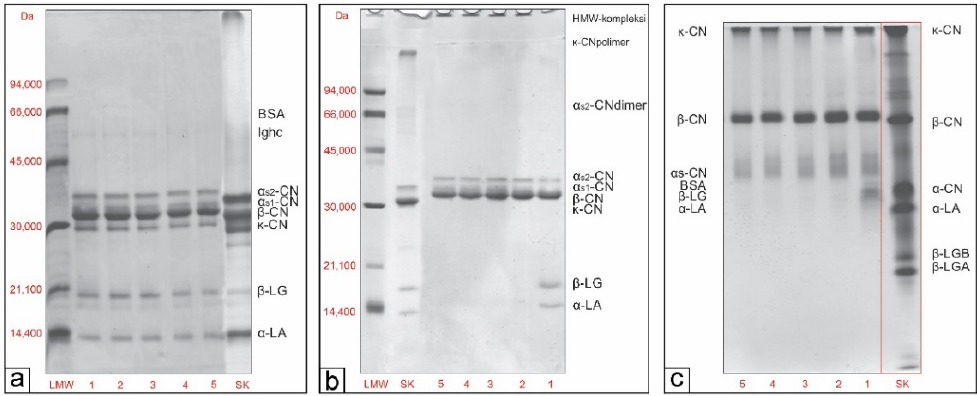
Figure 1. Electrophoretic patterns of M, TM and TME powders, analysed by SDS-PAGE in reducing conditions (SDS-R-PAGE) ( a ); SDS-PAGE in non-reducing conditions (SDS-NR-PAGE) ( b ); and native PAGE (Native-PAGE) ( c ). Lines: 1-Skimmed goat’s milk powder-M; 2-Skimmed thermally treated goat’s milk powder-TM; 3-Skimmed thermally treated goat’s milk/seed extract powder (0.2 mgTPC/mL)-TME1; 4-Skimmed thermally treated goat’s milk/seed extract powder (0.4 mgTPC/mL)-TME2; 5-Skimmed thermally treated goat’s milk/seed extract powder (0.6 mgTPC/mL)-TME3; Molecular weight standard (LMW); Bovine milk protein standard (SK). Abbreviations: bovine serum albumin (BSA); immunoglobulin hard chain (Ighc); α s2-casein ( α s2-CN); α s1-casein ( α s1-CN); β -casein ( β -CN); κ -casein ( κ -CN); β -lactoglobulins ( β -LG); α -lactalbumin ( α -LA).